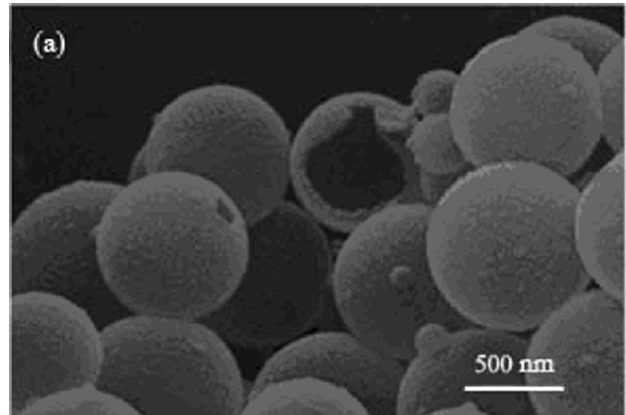
Figure 1. Scanning electron microscopy (SEM) images of ( a ) SiO ( b ) K-3% SiO , and ( c ) K-7% SiO 2